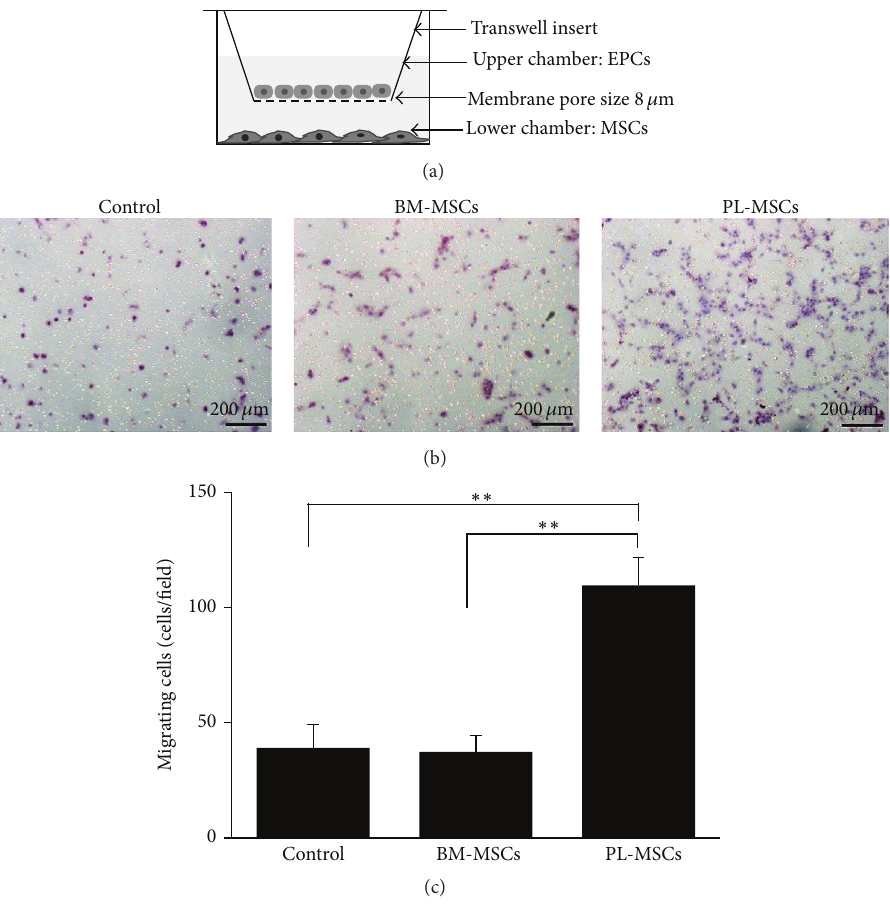
Figure 3: Effects of soluble factors released from BM-MSCs and PL-MSCs on EPC migration. (a) Diagram of the transwell culture system for an in vitro migration assay. (b) Hematoxylin stained EPCs which migrated to the other side of transwell membrane in response to soluble factors released from BM-MSCs and PL-MSCs. EPCs cultured in transwells containing serum-free medium (SFM) serve as negative controls. (c) Number of EPCs which migrated in response to soluble factors released from BM-MSCs and PL-MSCs. Data were presented as mean ± SEM of three independent experiments. Mann-Whitney 𝑈 test was used to assess the significance of differences between observed data. ∗∗ 𝑃 < 0.01 .